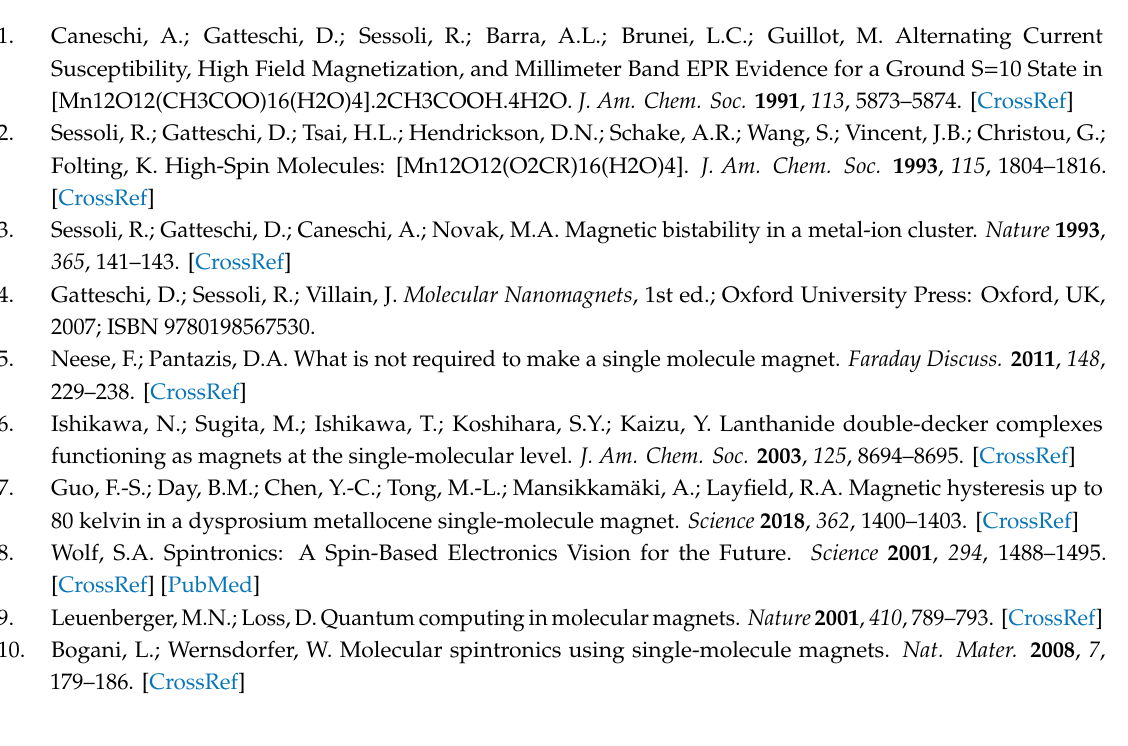
Supplementary Materials: The following are available online. Table S1: Comparison of Raman shift peaks (in cm − 1) for drop-casting. Peak intensity is denoted as follows: strong—s, medium—m, and weak—w. Figure S1: AFM images from drop-cast and sublimated samples at 75 and 265 ◦ C. Figure S2: Weak Co 2p peak from the drop-cast sample. Figure S3: Elemental percentage of atoms in powder from crucible after thermal sublimation at 75 and 265 ◦ C. Deposition Number 2034425 (1) contains the supplementary crystallographic data for this